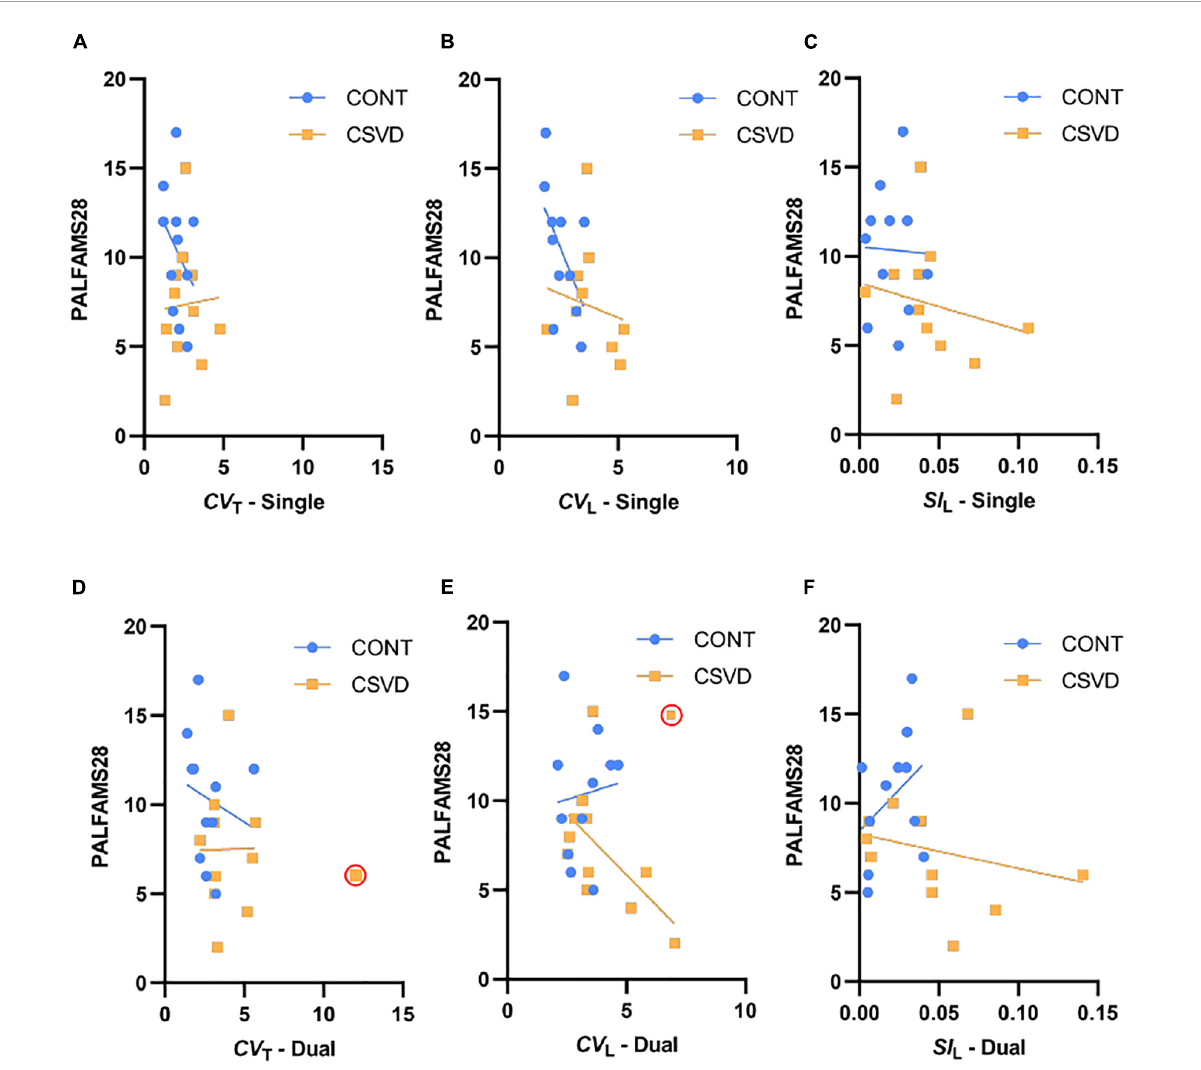
FIGURE5 Relationship between gait parameters and Paired Association Learning First Attempt Memory (PALFAMS28) score. PALFAMS28 scores are plotted as a function of Step Time Coefficient of Variation [ CV T , panels (A,D) ], Step Length Coefficient of Variation [ CV L , panels (B,E) ] and Step Length Symmetry [ SI L , panels (C,F) ]. Data of patients with cerebral small vessel disease (CSVD, n = 11) are shown as orange squares while those of age- and sex-matched control participants (CONT, n = 11) are shown as light blue circles. Top and bottom panels display gait parameters during single and dual task conditions respectively. Trendlines are displayed for each group separately with the corresponding color. PALFAMS28 scores were not associated with any of the gait